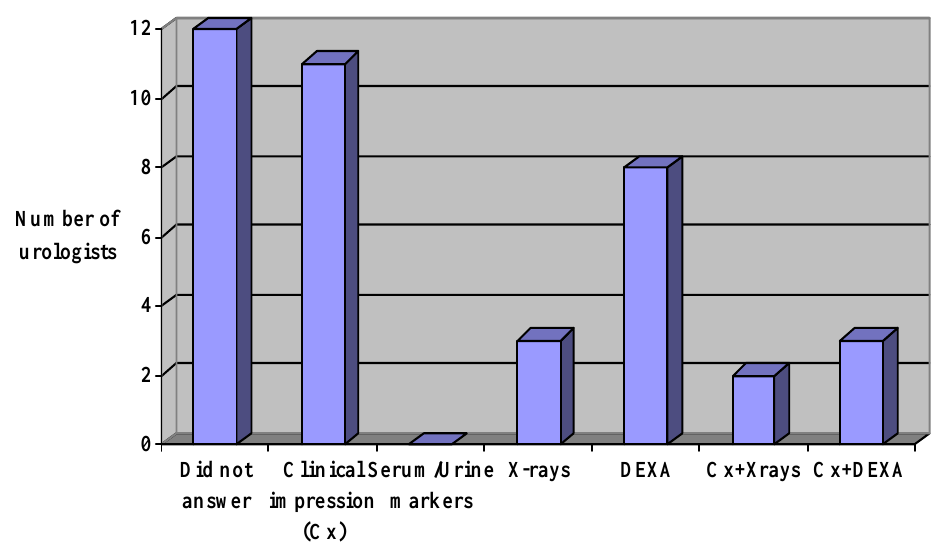
FIGURE 1. Methods for the assessment of bone